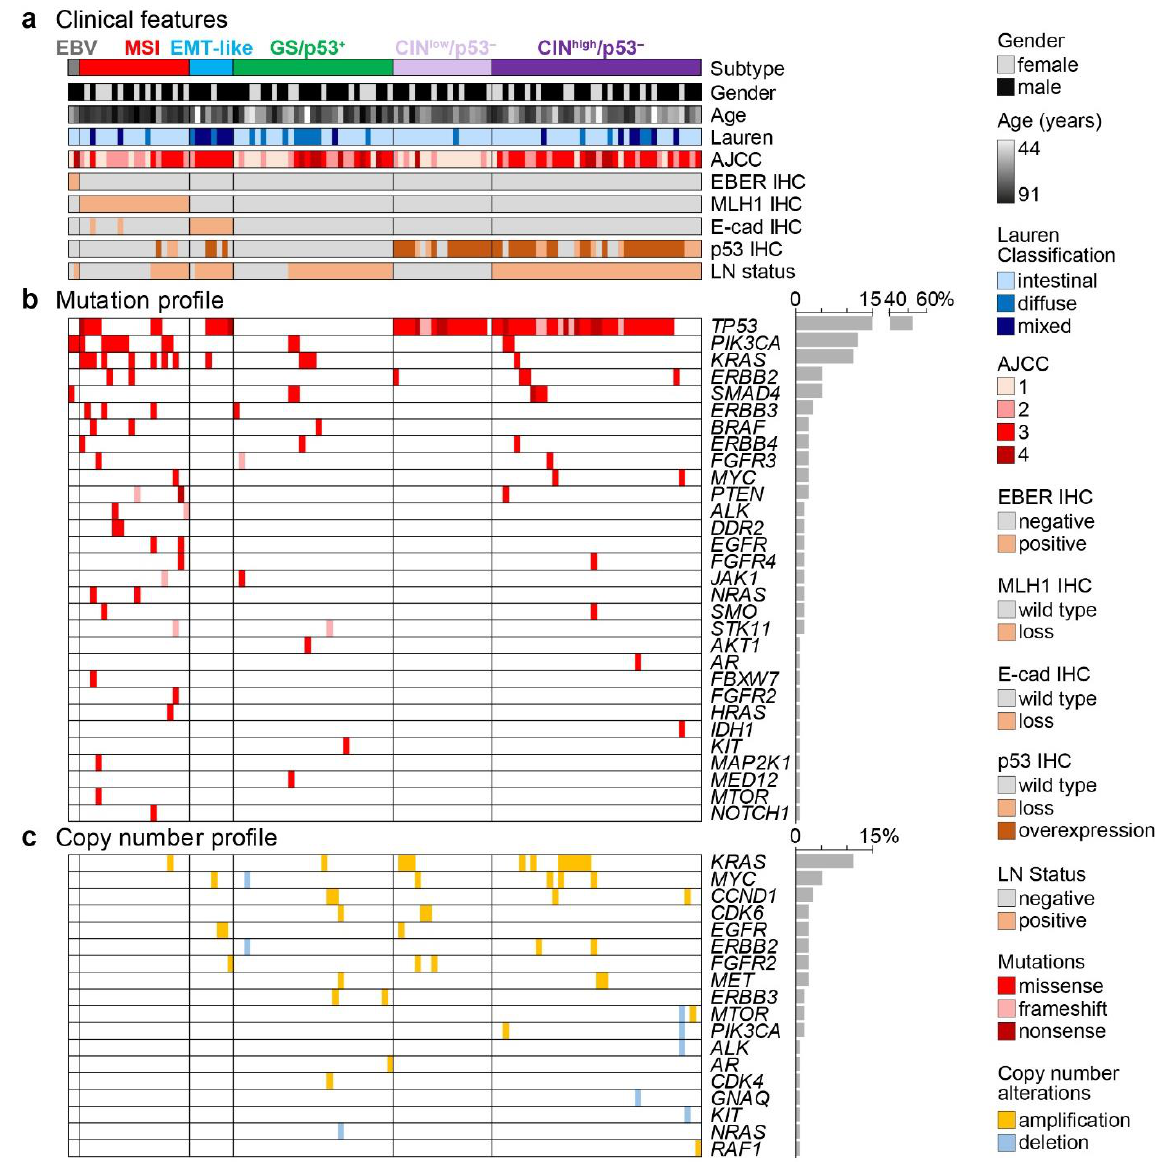
Figure 4. Gastric adenocarcinoma were divided into subtypes: Epstein – Barr virus (EBV)-positive (grey), microsatellite instable (MSI; red), epithelial-mesenchymal transition (EMT)-like (blue), genomic stable/p53 unaffected (GS/p53 + ; green) and chromosomal instable/p53 aberrant (CIN/p53 − ; violet). CIN/p53 − tumors were further divided according to the absence (light violet) or presence of lymph node metastasis (dark violet). Oncoprint panel displaying: ( a ) Clinical data, histology and immunohistochemistry, ( b ) Mutation profiles and ( c ) copy number variation.